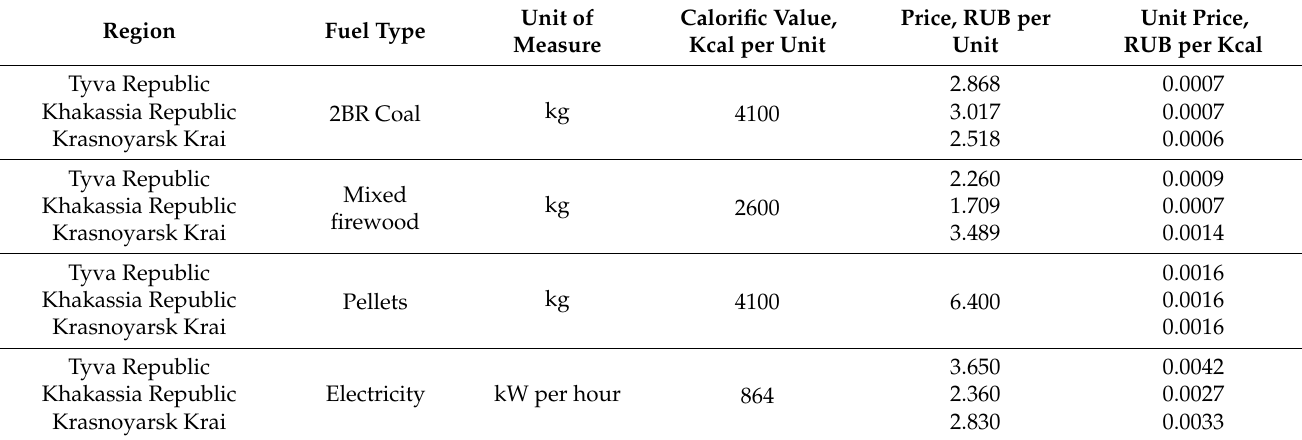
Table 8. Characteristics of fuel for individual heating. Source: Rosstat data. Region